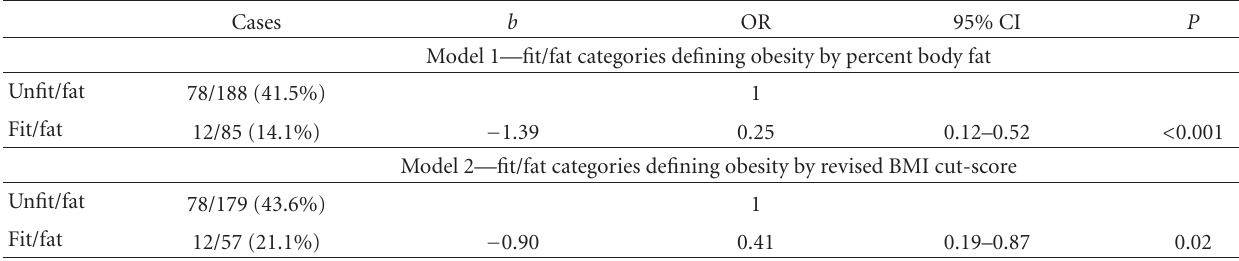
Table 3: Logistic regressions predicting metabolic syndrome by unfit/fat and fit/fat categories using two body composition methods.